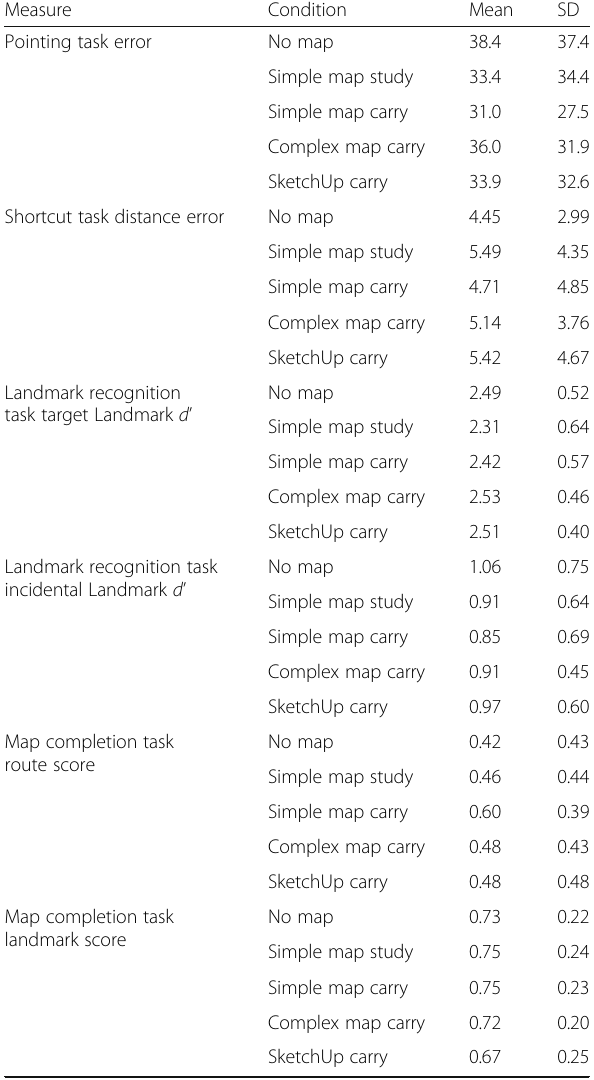
Table 3 Mean values and standard deviations (SDs) for each measure by map study condition Measure Condition Pointing task